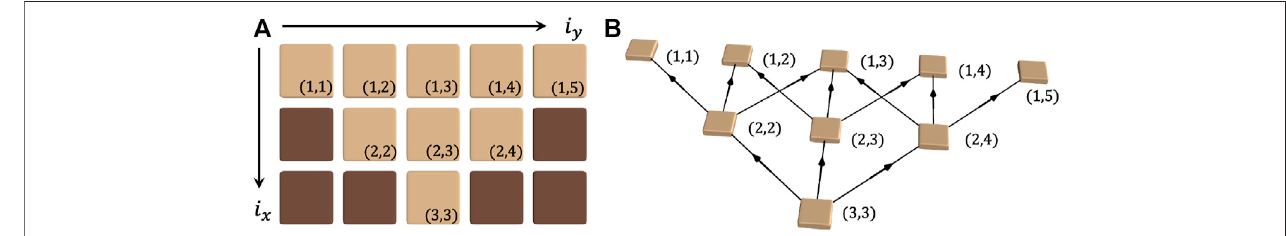
FIGURE2| Two-dimensionalopen-pitminingproblemandtheequivalentgraphrepresentation. (A) Aschematicoftwo-dimensionalopen-pitminingproblem.The blocks in light brown are excavatable. The blocks in dark brown are unexcavatable due to 45 ° slope constraint. i x and i y represent the vertical and horizontal indices, respectively. (B) The schematic for a directed graph representing a problem equivalent to the two-dimensional open-pit mining in panel (A) . Each node i = ( i x , i y ) represents a mining block. Each directed edge ( i , j ) ∈ V represents the physical constraint: if block i is excavated, block j should be excavated too.